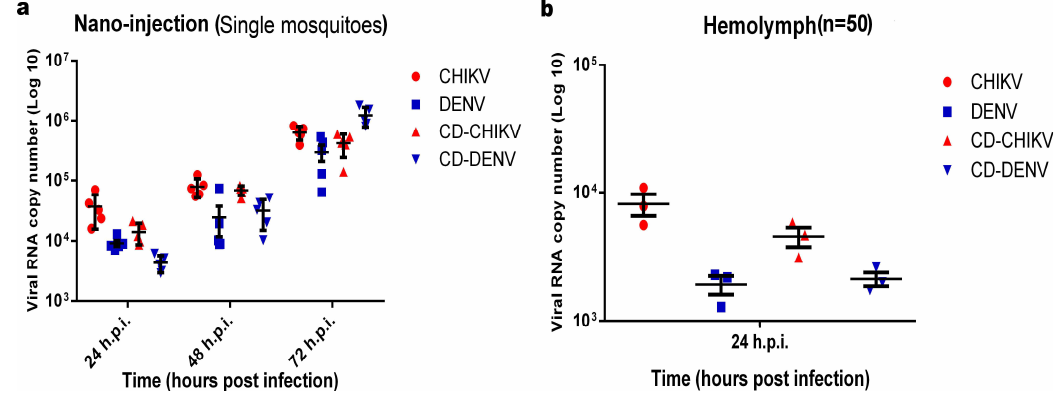
Figure 1. The figure shows quantification of viral RNA copies scaled to log 10. ( a ) Individual mosquitoes were checked for the presence of CHIKV and DENV RNA copies in both mono-infection and co-infection; ( b ) Hemolymph of infected mosquitoes were pooled and viral RNA copies were quantified at 24 h.p.i.